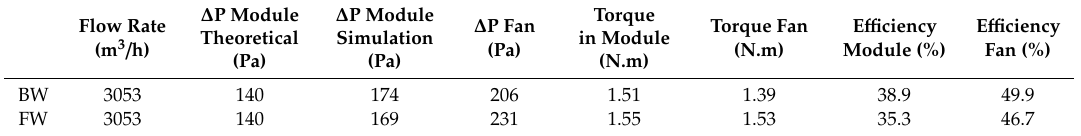
Table 1. Compared performances of BW and FW fans, with or without the heat exchanger.